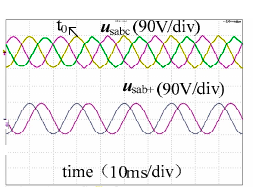
Figure 6. Schematic diagram of MRSMC for a DFIG system.